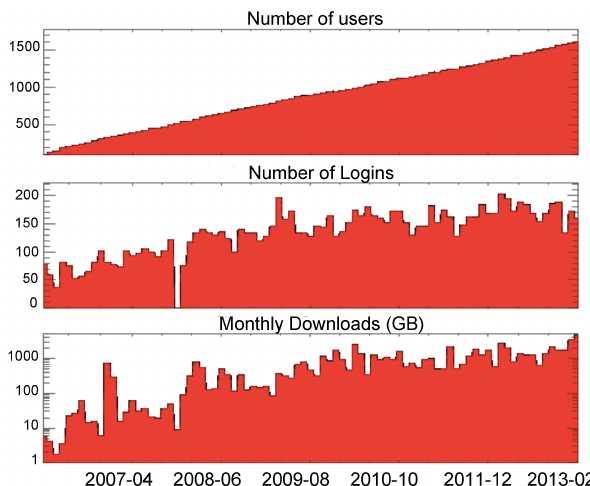
Fig. 13. Cluster Active Archive statistics from the opening in Febru- Figure 13. Cluster Active Archive statistics from the opening in Feb 2006 to now. The 3 ary 2006 to now. The number of users are shown at the top, the number of users are shown at the top, the number of logins per month in the middle and the 4 number of logins per month in the middle and the monthly down- monthly download rate (in Gbytes) at the bottom. 5 load rate (in Gbytes) at the